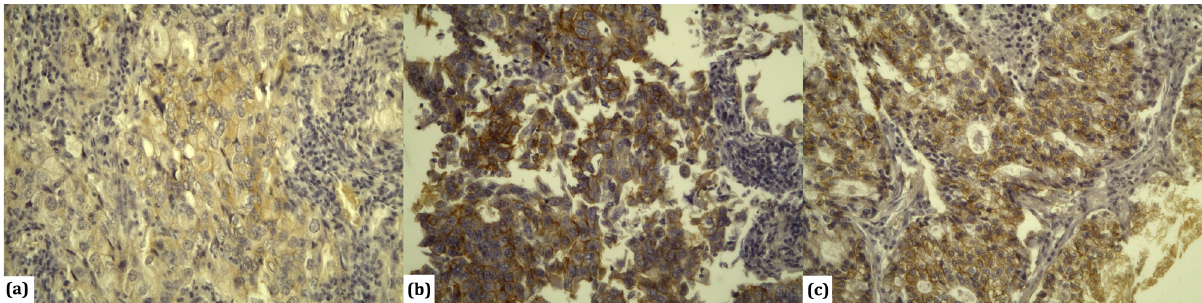
Figure 2: Immunohistochemical detection of HER2 antibody Ventana anti - HER2/neu ( 4B5 ) in lung adenocarcinoma: ( a ) tumours with poor, incomplete membrane – negative 1 + (× 200 ) ; ( b ) tumours with strong, incomplete basolateral dying in more than 10% of tumour cells – positive 2 + (× 200 ) ; and ( c ) tumours with strong, complete membrane dying in more than 10% of tumour cells - positive 3 + (× 200 ) .